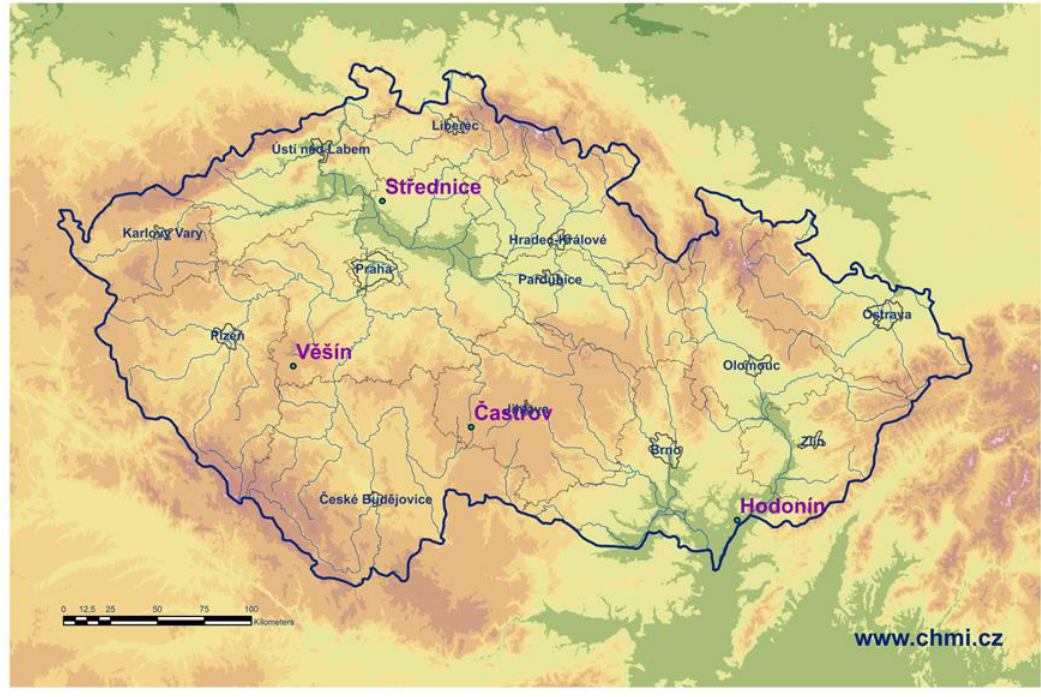
Figure 1. Location of the selected phenological stations (highlighted in violet).